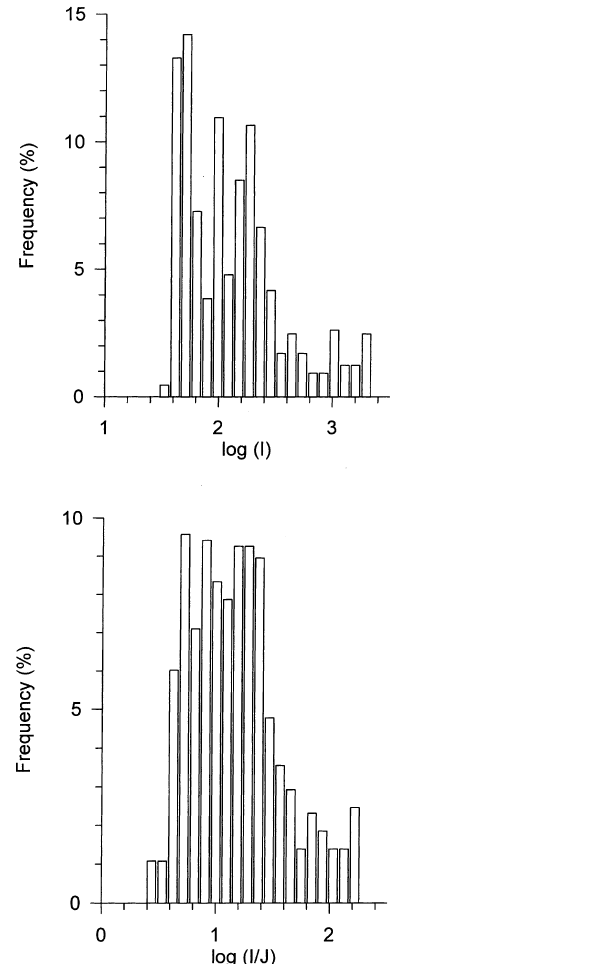
Fig. 3. Histograms for I 1 (cid:136) log (cid:133) I (cid:134)(cid:133) top (cid:134) and I 2 (cid:136) log (cid:133) I = J (cid:134) ( bottom ), where I is the SAR arc intensity and J is given by Eq. (7)